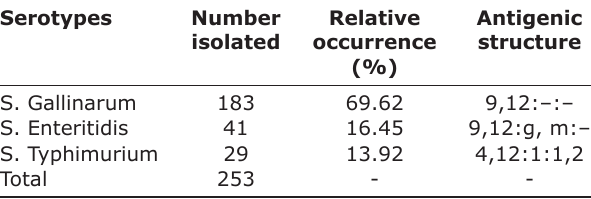
Table-3: Distribution of different serotypes of Salmonella isolated from poultry from some parts of Haryana.